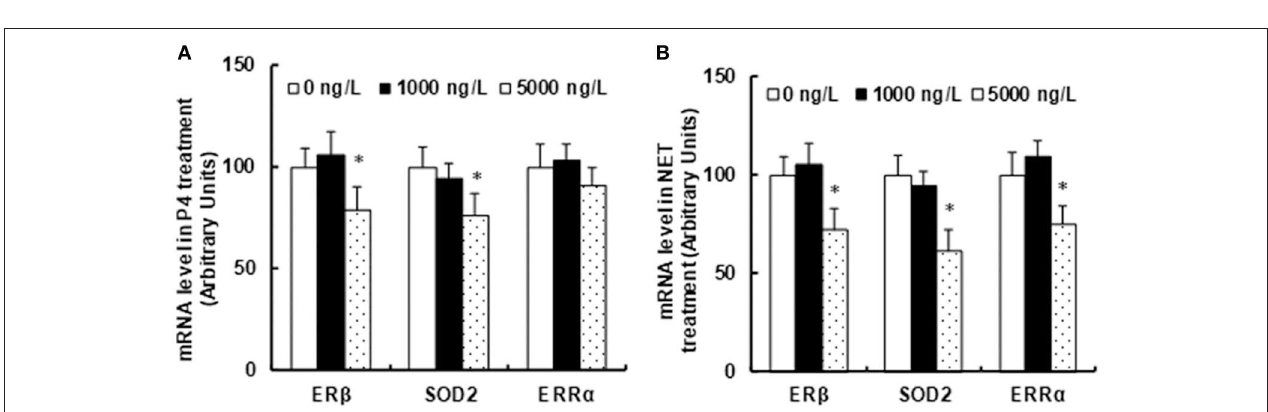
FIGURE 2 | Prenatal consumption of progestin-contaminated seafood suppresses ER β expression and its target genes in the amygdala of offspring in rats. Three months old pregnant dams were fed with progestin (P4 or NET)-contaminated seafood continuously for 21 days until pup delivery. The amygdala from both male and female offspring at 10 weeks of age were isolated for the analysis of mRNA expression. (A) mRNA level in P4 treatment. (B) mRNA levels in NET treatment. n = 5,* P < 0.05, vs. 0 ng/L group. Results are expressed as mean ±